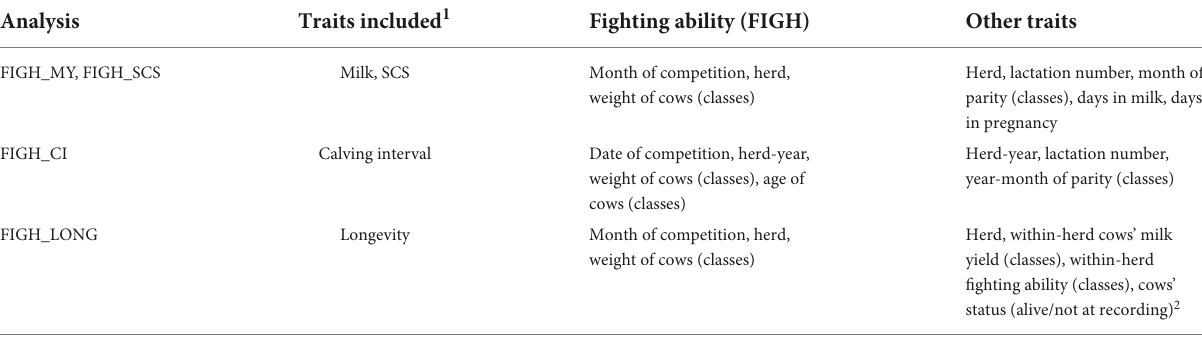
TABLE 2 Fixed effects accounted for analysis of traits in bivariate animal models.